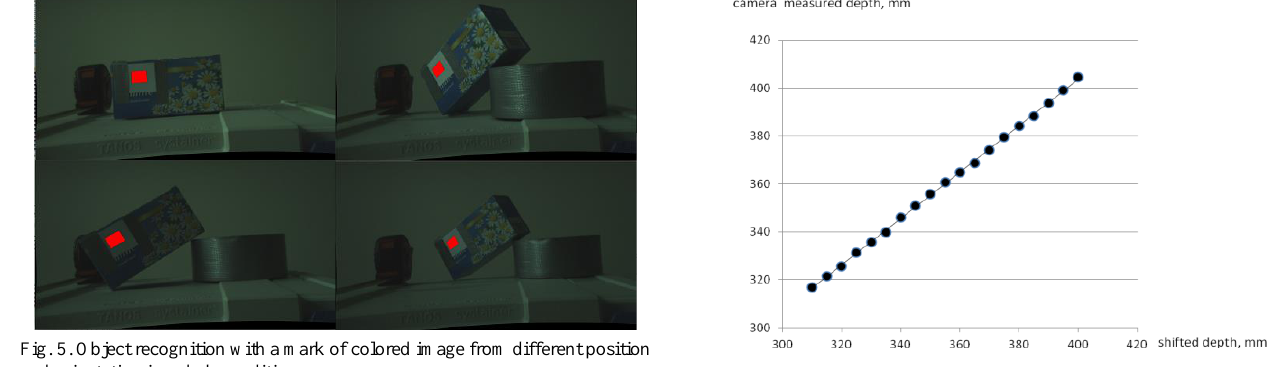
Fig. 9. Camera measured depth versus shifted